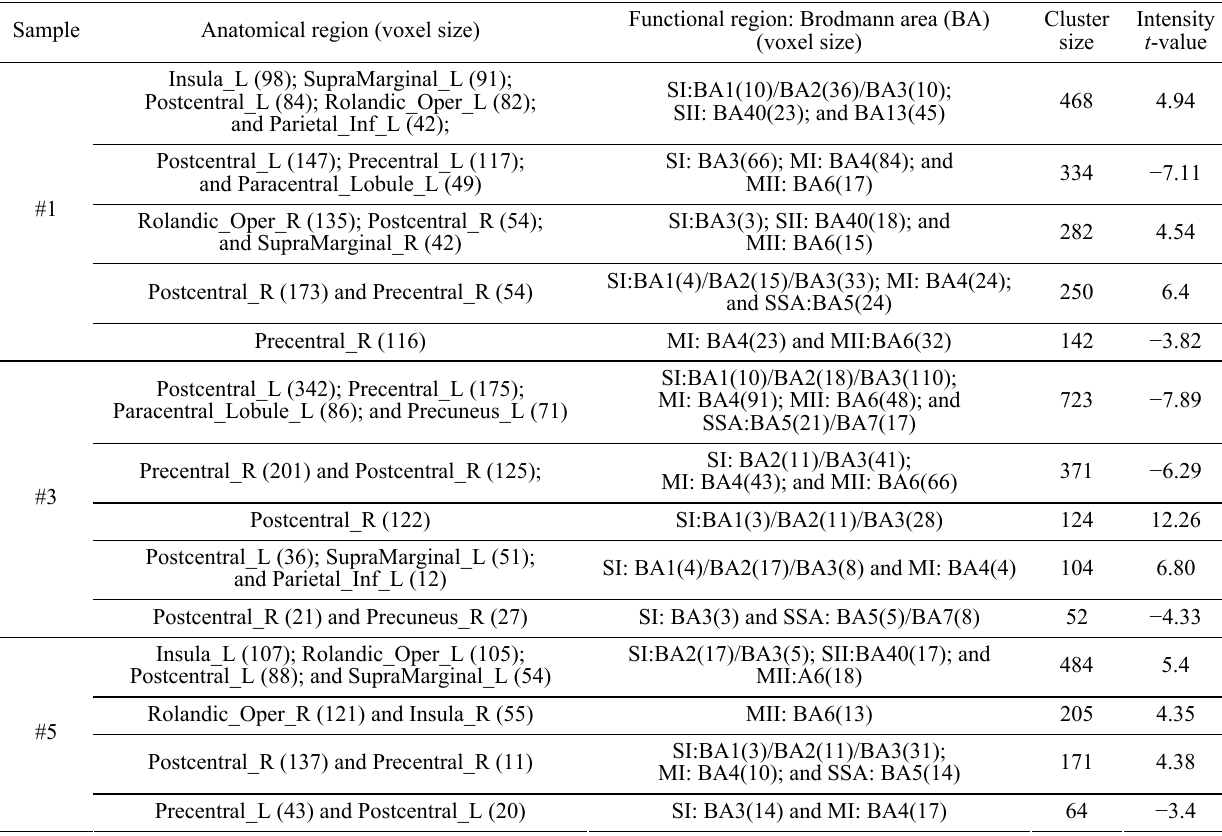
Fig. 9 Brain slice maps and three-dimensional (3D) images of the tactile stimulation of (a) #1, (b) #3, and (c) #5 fabric samples. Table 4 Brain tactile activation information of the three fabric